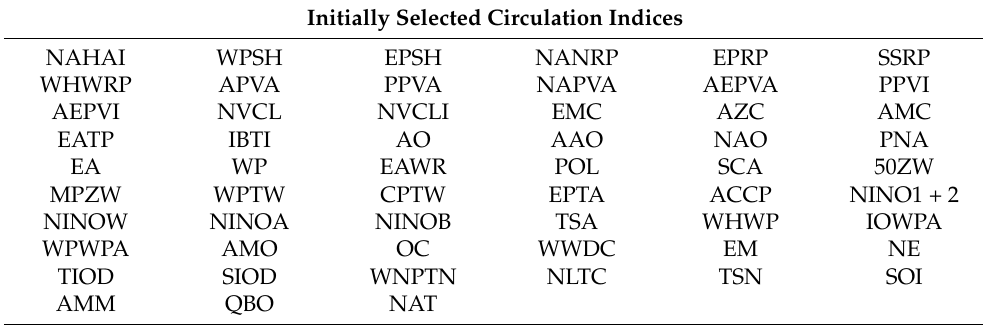
Table 1. The initially selected 57 circulation indices from the 100 indices with VIF < 10 through multi-collinearity analysis (consistent at the 44